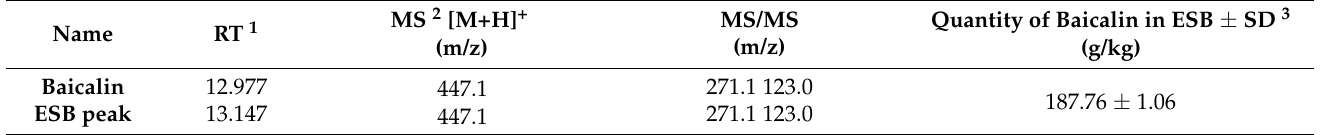
Figure 1. Identification of baicalin from ESB by HPLC-MS analysis. Total HPLC-chromatograms of baicalin ( A ) and ESB ( B ) were obtained at a UV wavelength of 275 nm. The molecular weight of the indicated peak in the chromatogram of baicalin ( A ) and ESB ( B ) was measured by HPLC-MS/MS analysis. ESB, ethanol extract of the root of Scutellaria baicalensis ; HPLC-MS, high-performance liquid chromatography-mass spectrometry; RT, retention time. Table 1. The spectral data and quantitative value of baicalin and ESB peak.